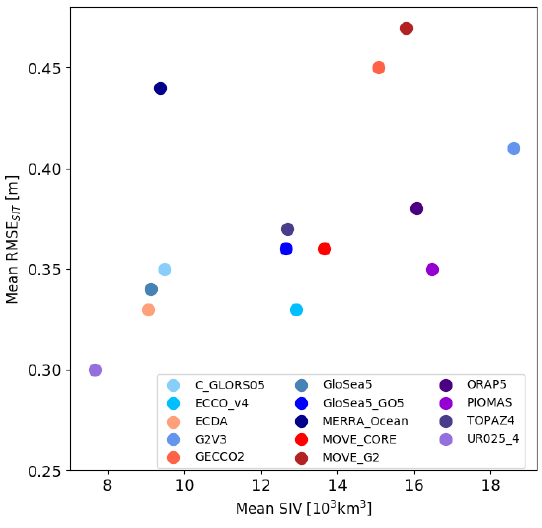
Figure 10. Time-mean sea ice volume vs. the mean RMSE. This last parameter is an average of the RMSEs that each reanalysis has when its SIT field is compared individually to the other 13 reanalyses, as shown in Fig. 5. Shades of blue and purple indicate the reanalyses which do assimilate sea ice data, while shades of red indicate the reanalyses without sea ice data assimilation.